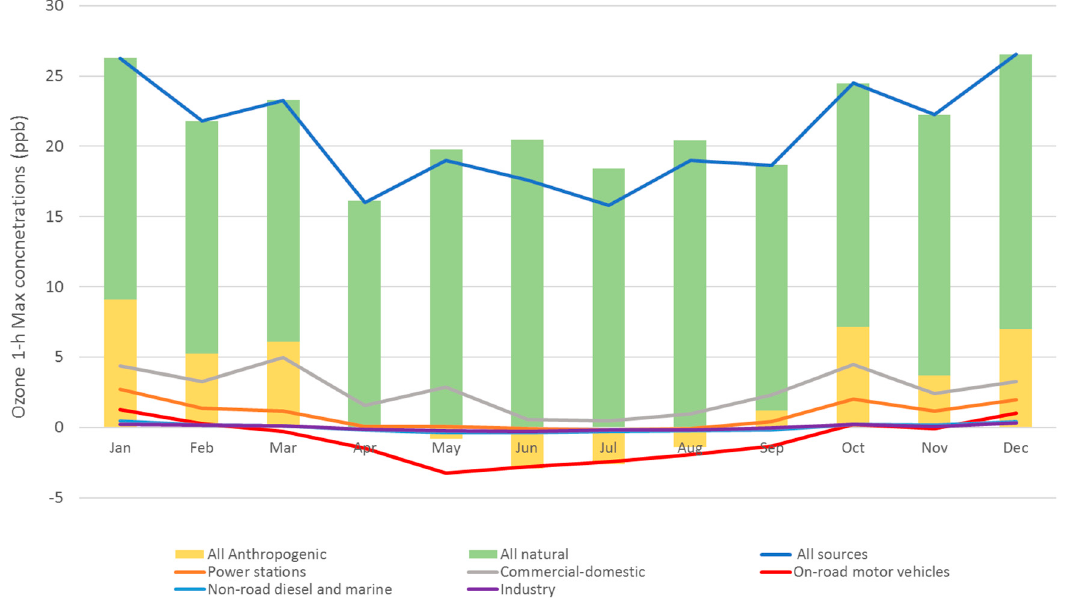
Figure 8. Contribution of all anthropogenic and natural emissions (bar graph) and different anthropogenic sources (line graph) to the monthly average of daily maximum 1-h ozone concentration in 2008 in the Sydney northwest region.